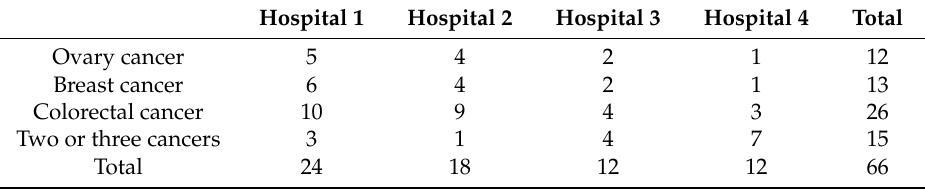
Table 1. Number of informants from the participating diagnoses and